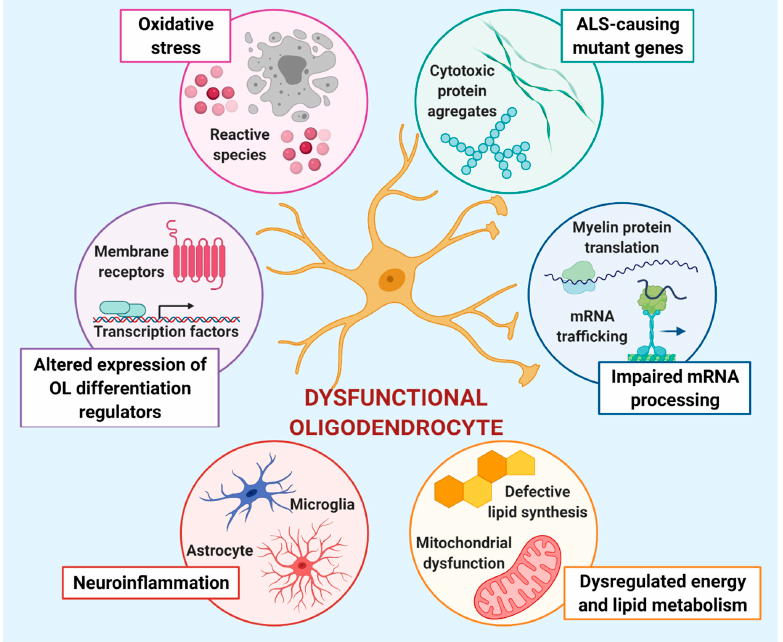
Figure 3. Mechanisms contributing to oligodendrocyte (OL) dysfunction and degeneration in ALS. The presence of ALS-related mutant genes in OLs has been shown to produce detrimental effects by inducing alterations of their normal func- tion or by the formation of cytotoxic protein inclusions. Moreover, given that several ALS-linked genes are involved in mRNA processing, impaired trafficking of myelin-associated mRNAs from the nucleus to cell processes and their transla- tion have been implicated in remyelination failure. Besides genetic mutations, other factors dysregulated in ALS may